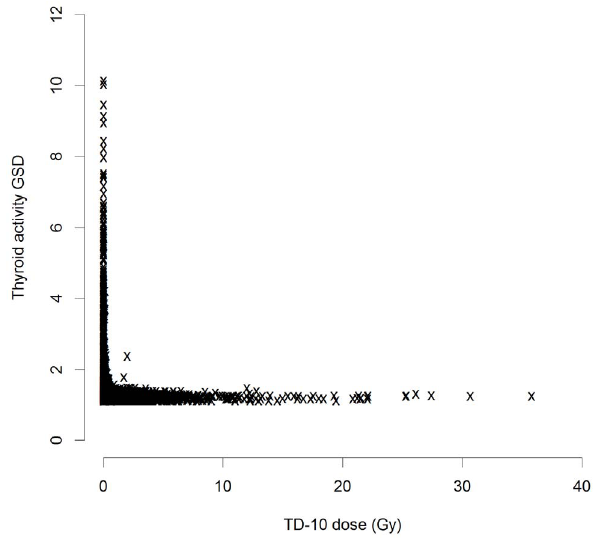
Figure 1. Distribution of the geometric standard deviation (GSD) of errors associated with assessments of thyroid activity GSD as a function of TD-10 thyroid dose. Full dose range.